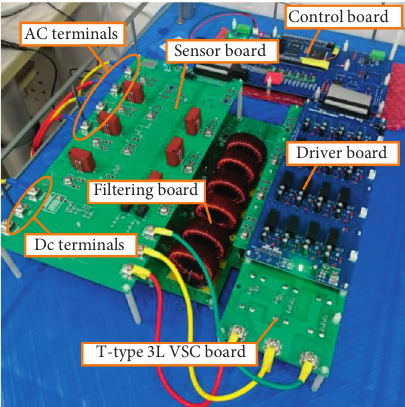
Figure 14: Photo of the experimental